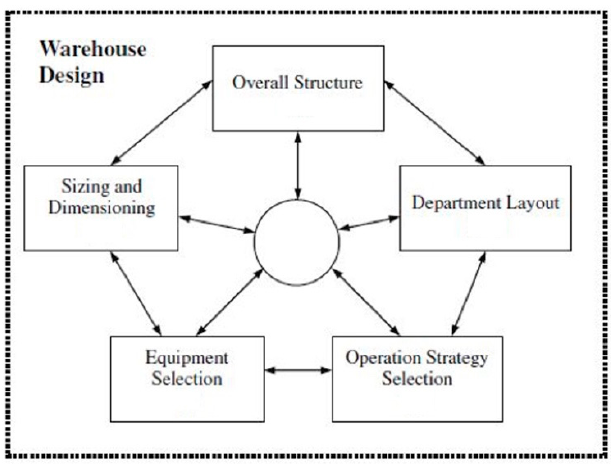
Figure 1. Warehouse Design.